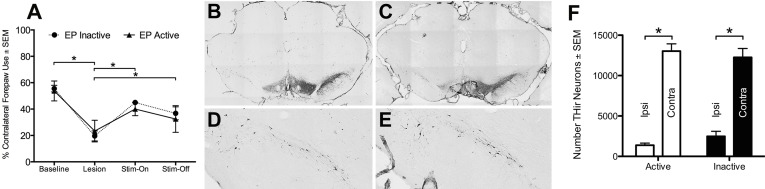
EP DBS does not correct forelimb asymmetry or provide neuroprotection from 6-OHDA.
(A) Rats receiving intrastriatal 6-OHDA followed by either ACTIVE or INACTIVE EP DBS were analyzed for forelimb use asymmetry in the cylinder. 6-OHDA led to a significant decrease in contralateral forelimb use. However, ACTIVE EP DBS showed no difference compared to INACTIVE DBS at any time point. Of note, two weeks following electrode implantation in the EP, an improvement in contralateral forepaw use was observed. (B-E) EP DBS does not provide neuroprotection from 6-OHDA. Neither ACTIVE nor INACTIVE EP DBS halted ongoing nigral DA neuron loss normally observed between two and four weeks after intrastriatal 6-OHDA. (B-C) Representative nigral sections from both INACTIVE (B) and ACTIVE (C) EP DBS rats labeled with TH antisera reveal significant depletion of nigral DA neurons in the lesioned hemisphere. (D-E) At higher magnification, DA neuron loss appears equivalent between the INACTIVE (D) and ACTIVE (E) treatment groups. (F) Stereological assessment of THir neurons revealed a significant effect of 6-OHDA administration but no significant difference between ACTIVE and INACTIVE EP DBS groups.